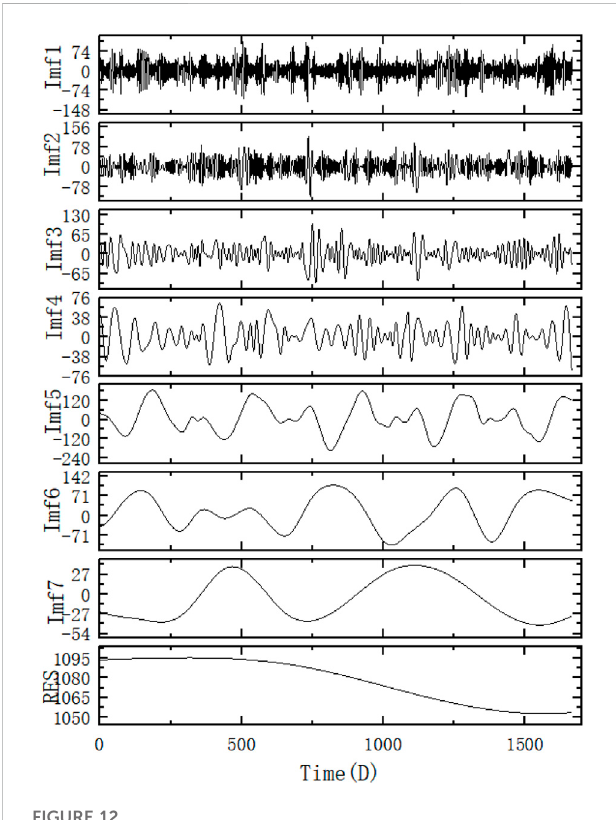
FIGURE 12 Results of the decomposition of Case 2 CEEMDAN.